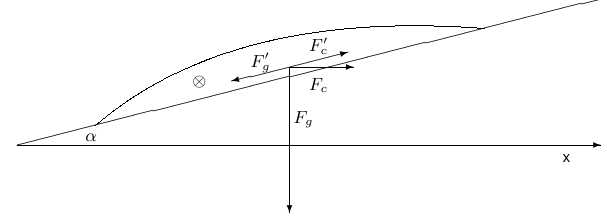
Fig. 1. Cross section of a gravity current with an average Fig. 11. Cross section of a gravity current with an average geostrophic velocity into the plane. The Coriolis force F c and the geostrophic velocity into the plane. The Coriolis force F c and the buoyancy force F g are shown. The figure establishes the force bal- buoyancy force F g are shown. The figure establishes the force bal- ance between the projection of the Coriolis force F 0 c and the projec- ance between the projection of the Coriolis force F ′ c and the projec- tion of the buoyancy force F ′ g onto the topographic slop, for a grav- tion of the buoyancy force F 0 g onto the topographic slop, for a grav- ity current on a inclined plane, of angle α , when dissipative pro- ity current on a inclined plane, of angle α , when dissipative pro- cesses are neglected. cesses are